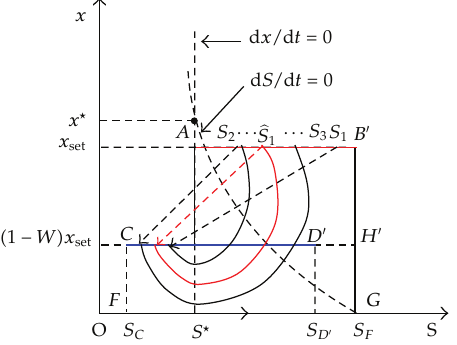
Figure 6: The trajectory of the solution (cid:5) S,x (cid:6) for the case where